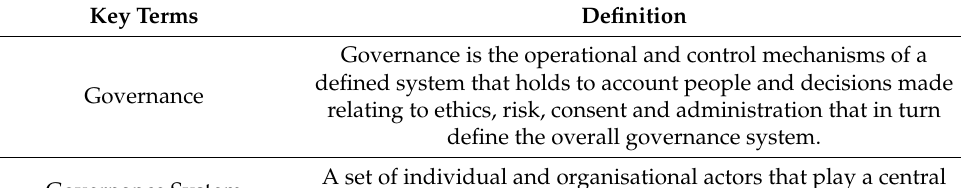
Table 1. Definition of key terms for the Culturally Adaptive Governance